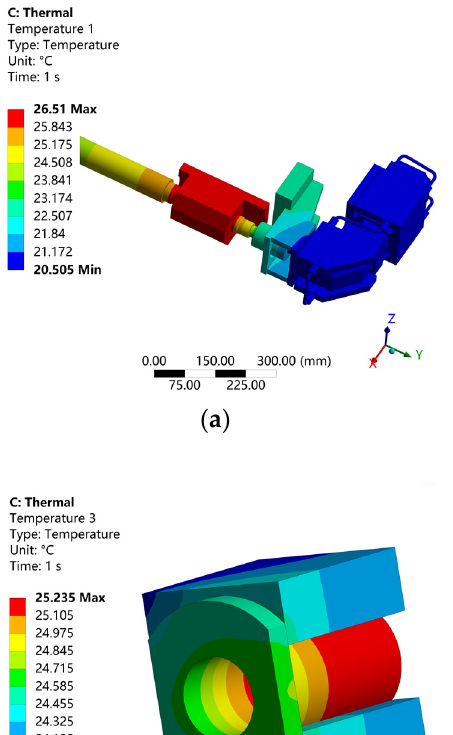
Figure 16. Positioning diagram of the temperature sensor of the Y-axis feeding system.